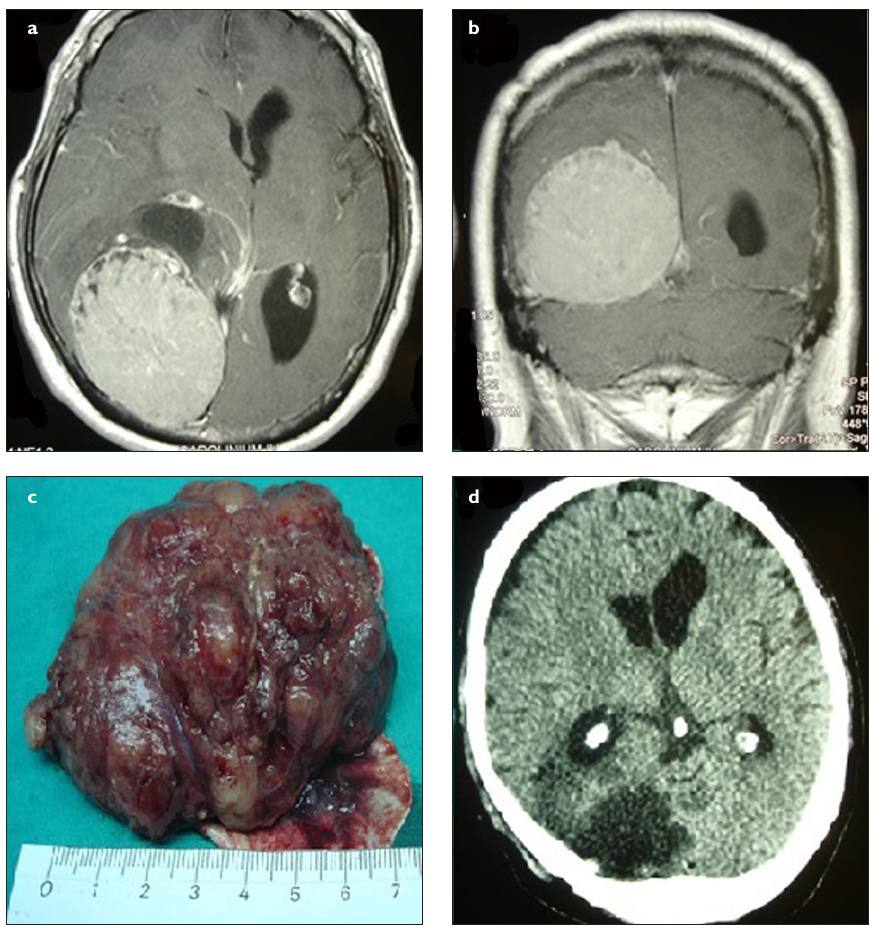
Figure 3. a-d. (a) Preoperative axial and (b) coronal MRI scans of a patient with giant left posterior parietal meningioma. There was a significant compression on the atrium of the left lateral ventricle. The patient underwent gross total resection including dura mater using left parietal craniotomy. (c) The tumor was larger than 6 cm. (d) Postoperative axial CT scan confirmed the total resection of tumor. CT, computed tomography; MRI, magnetic resonance